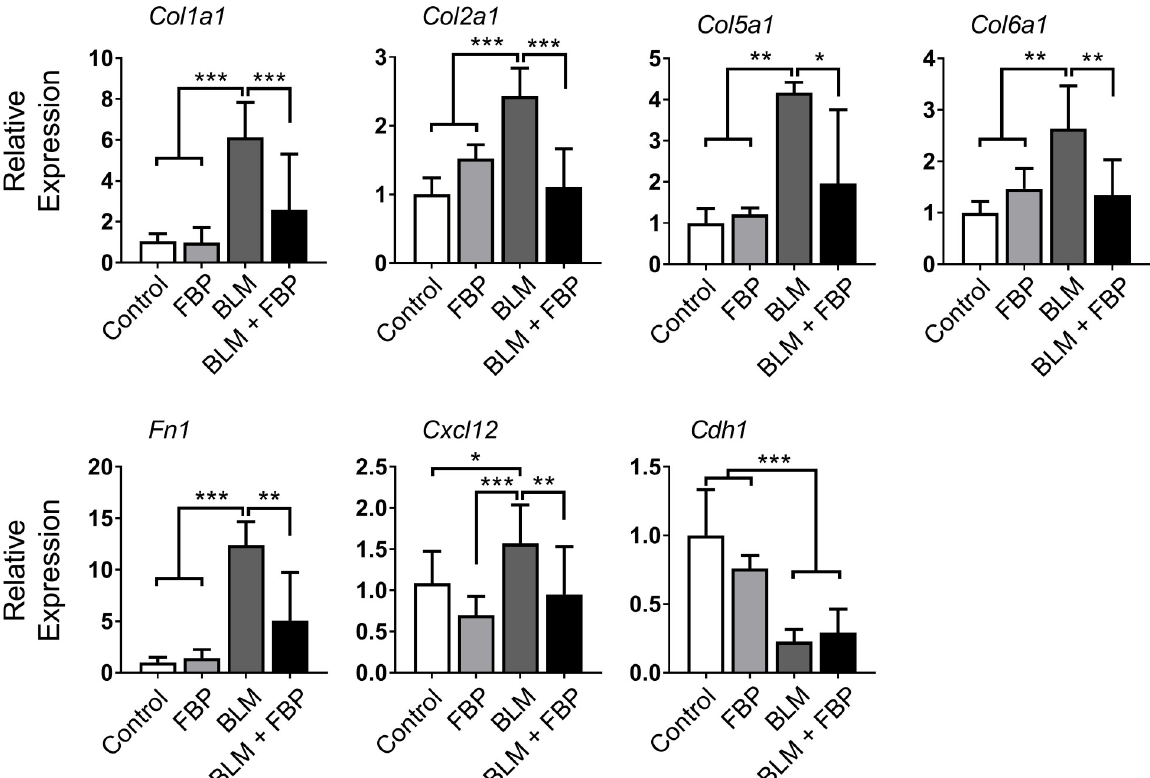
Fig 3. Fructose-1,6-bisphosphate regulates extracellular matrix-related genes in vivo . qRT-PCR analysis of mRNA encoding for collagen subtypes, collagen 1a1 ( Col1a1 ), collagen 2a1 ( Col2a1 ), collagen 5a1 ( Col5a1 ), collagen 6a1 ( Col6a1 ), and Fn1 , Cxcl12 and Cdh1 . One-way ANOVA followed by Tukey’s multiple comparison test was used. Relative expression is presented based on the expression level of control as 1. Values are expressed as mean ± SD; n = 6–12/group; � p < 0.05; �� p < 0.01; ��� p <